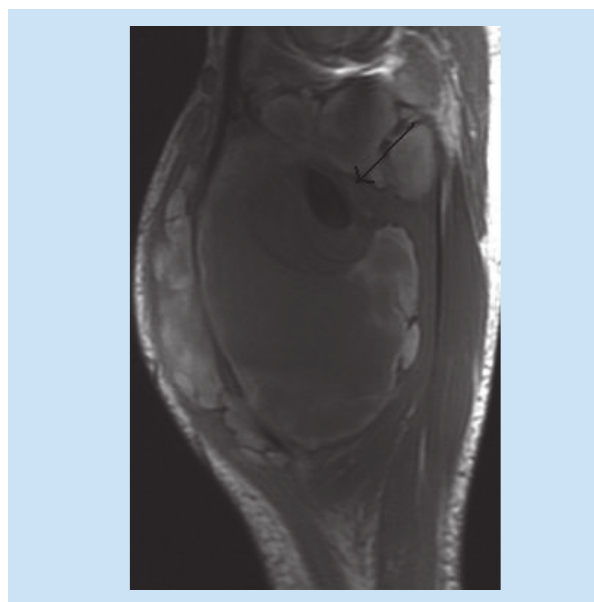
Fig. 1a. Patient with a few months’ history of an enlarging mass in the right thigh. Sagittal T1 shows a complex cystic mass with a central signal void (arrow).